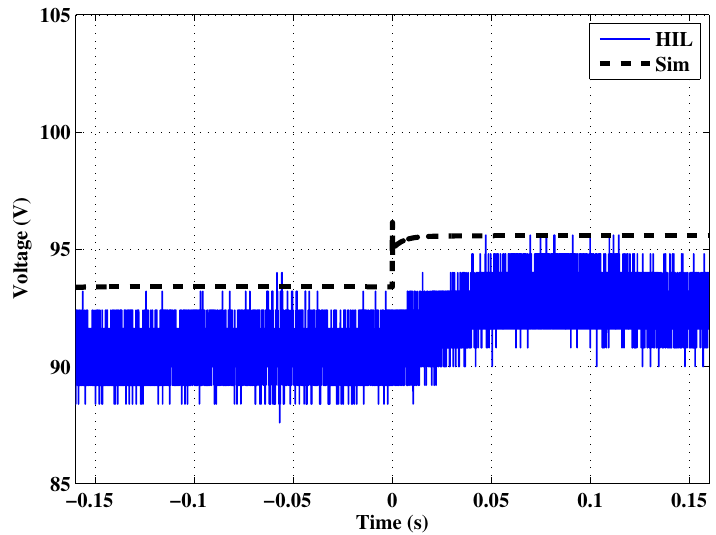
Figure 10. Simulation and hardware-in-the-loop results for bus voltage during a step change in wind speed.